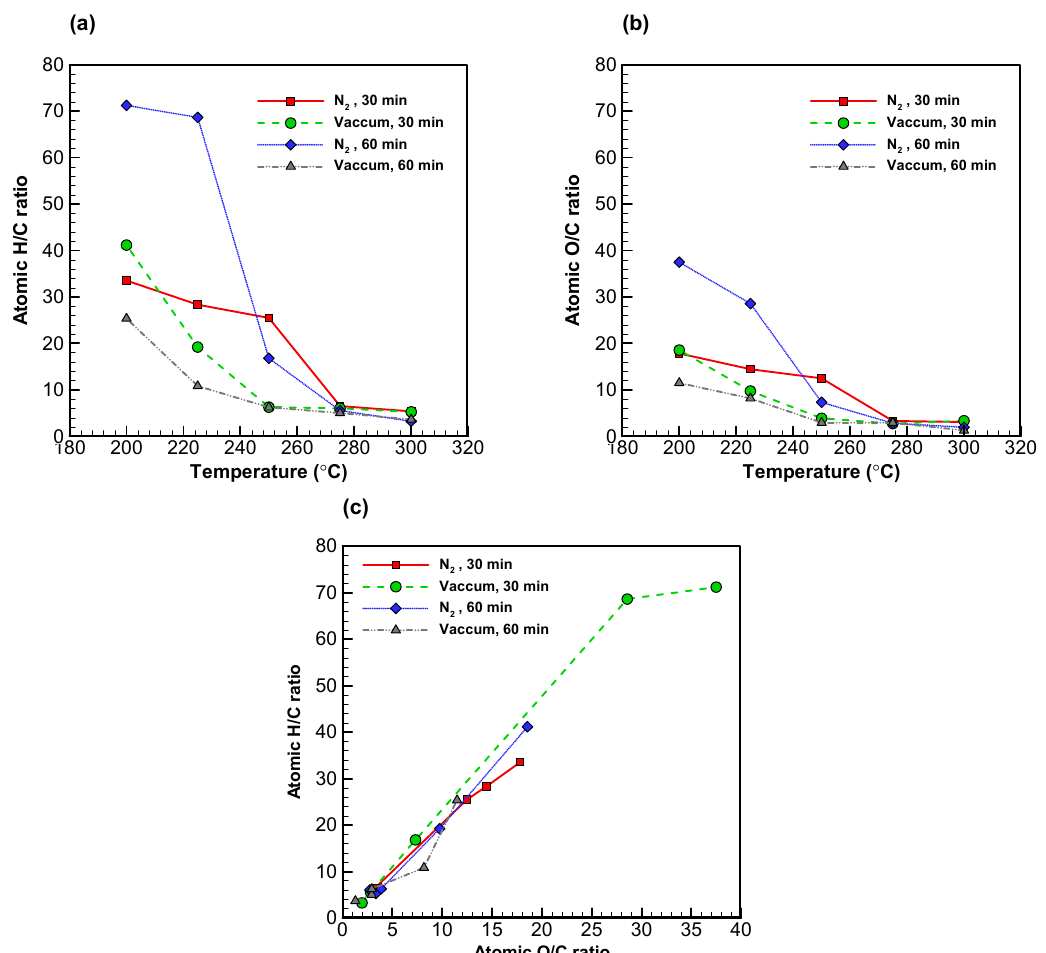
Figure 4. Profiles of ( a ) atomic H / C ratio versus temperature, ( b ) atomic O / C ratio versus temperature, and ( c ) van Krevelen diagram. All of the data presented were of low volatility compounds.